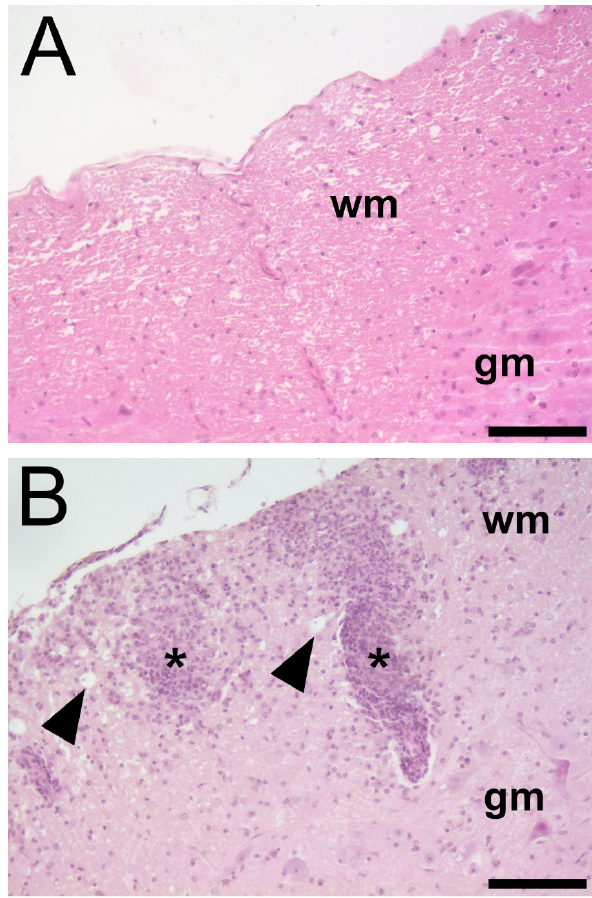
Fig. 4. Morphology of the spinal cord in the control and experi- mental autoimmune encephalomyelitis (EAE) mice. A. Image of white matter of the spinal cord from the control healthy animal. Structure of the spinal cord is well-preserved, and no inflammatory infiltration is present. B. Image of white matter of the spinal cord from an animal with EAE. Two inflam- matory foci are visible (asterisk) together with multiple swollen axons (arrowheads). Hematoxylin-eosin staining. Scale bars in A-B=50 µm. wm = white matter; gm = gray